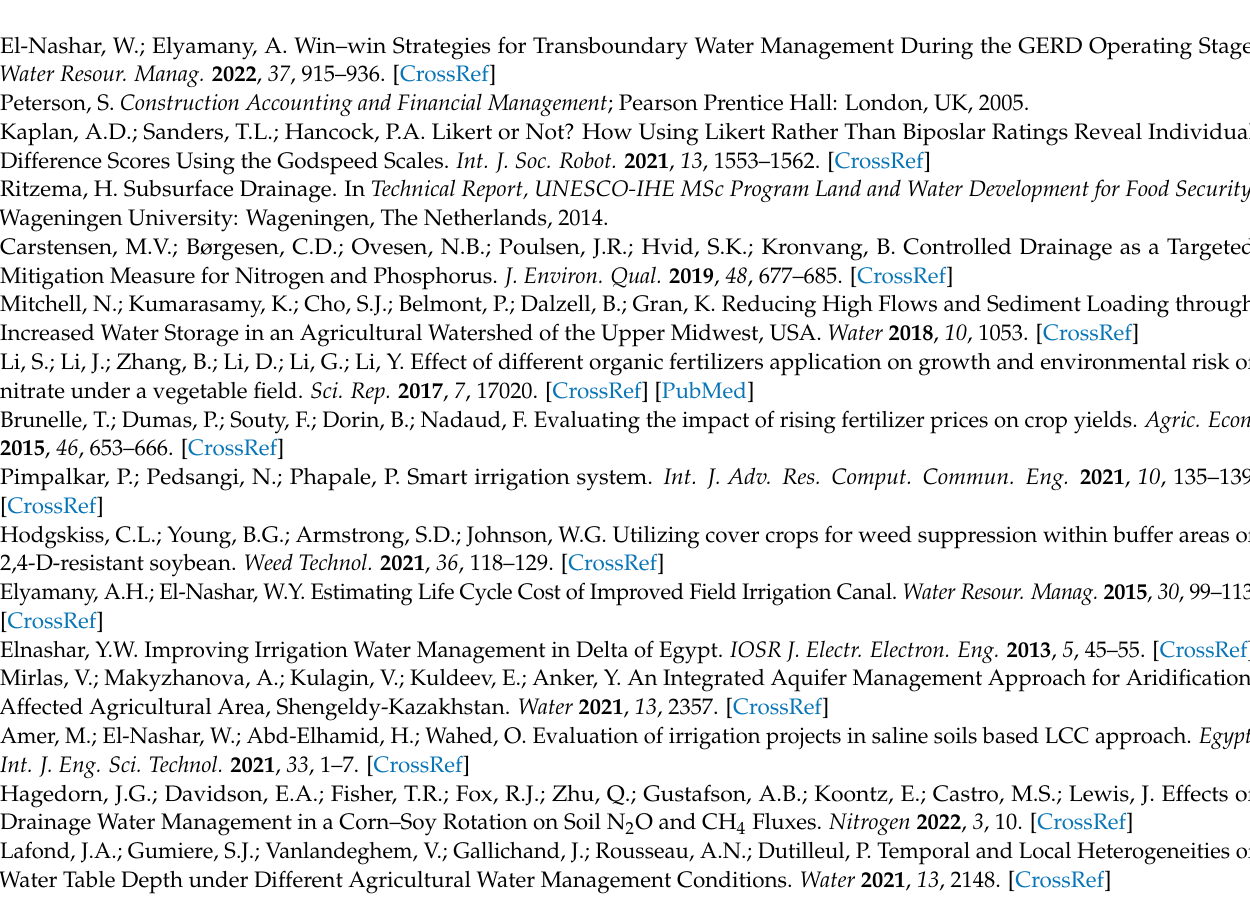
Water Table Depth under Different Agricultural Water Management Conditions. Water 2021 , 13 , 2148. [CrossRef] Disclaimer/Publisher’s Note: The statements, opinions and data contained in all publications are solely those of the individual author(s) and contributor(s) and not of MDPI and/or the editor(s). MDPI and/or the editor(s) disclaim responsibility for any injury to people or property resulting from any ideas, methods, instructions or products referred to in the